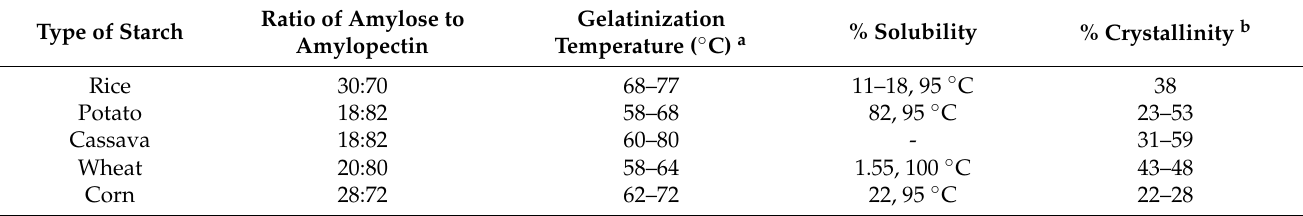
Table 1. Properties of native starch